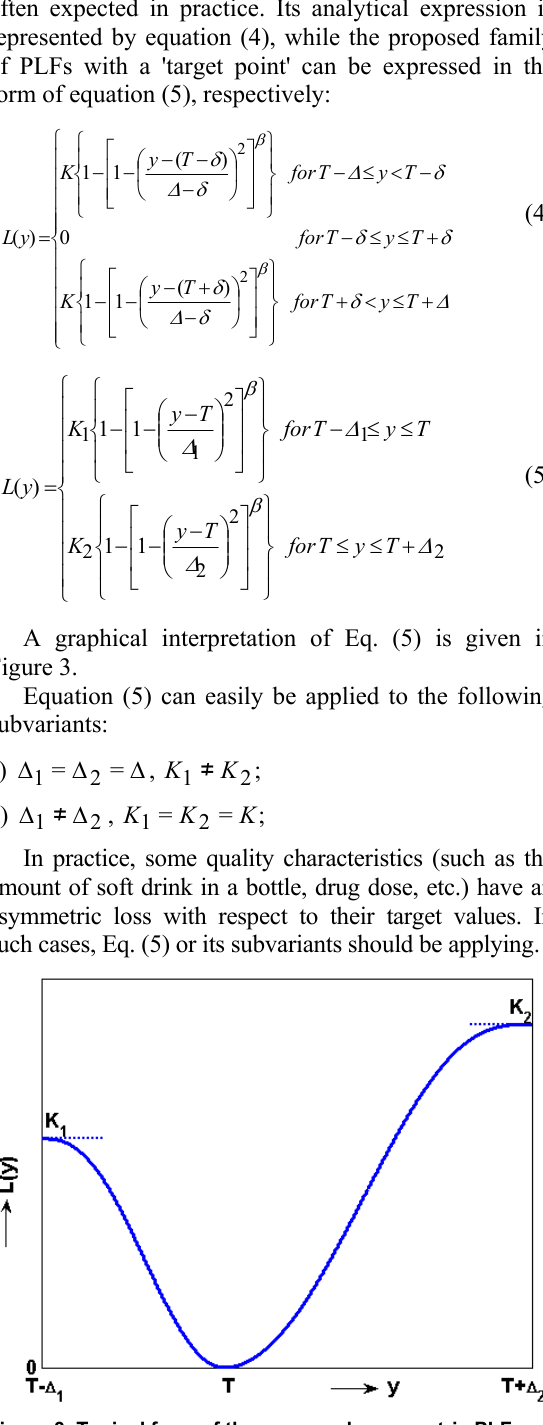
Figure 3. Typical form of the proposed asymmetric